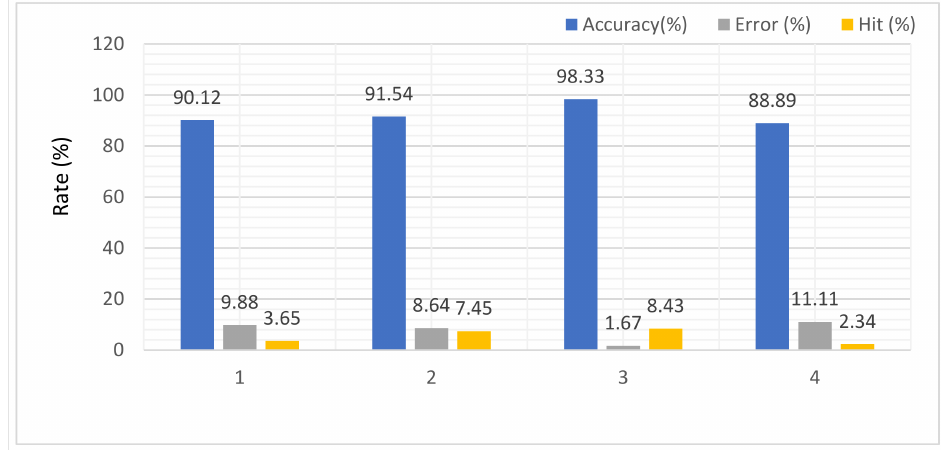
Figure 11. Self-collected images performance from the video.